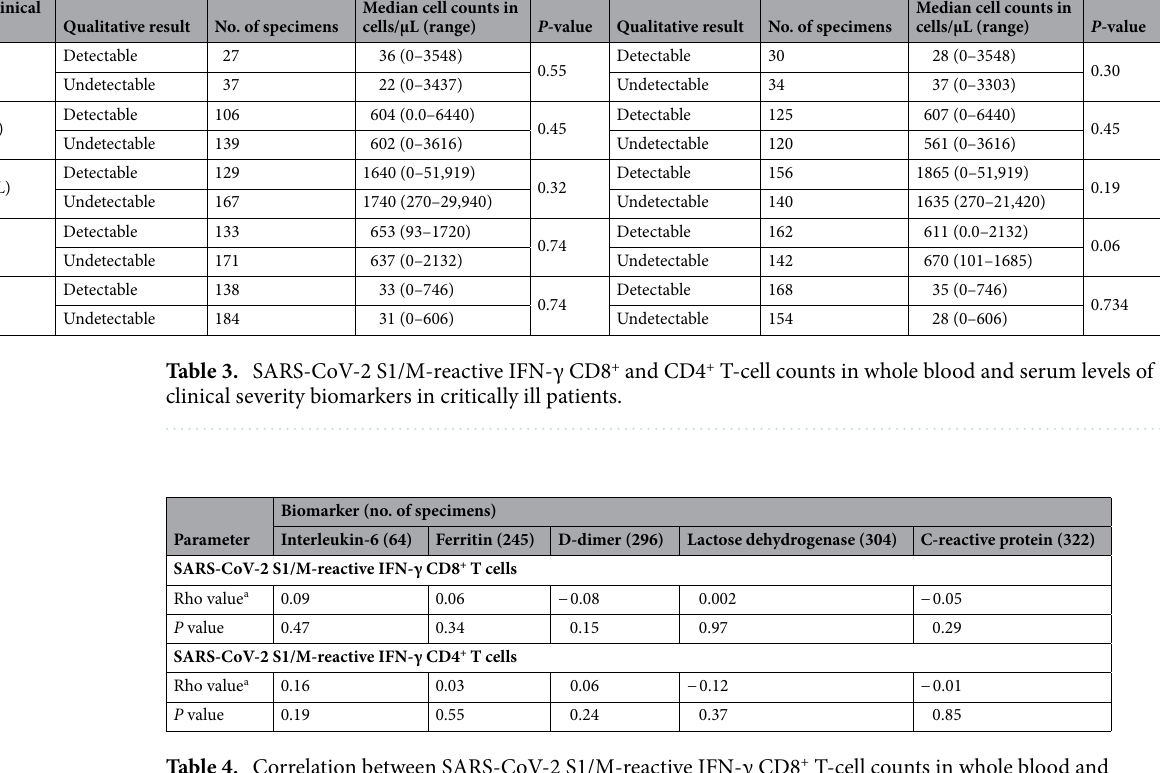
Table 4. Correlation between SARS-CoV-2 S1/M-reactive IFN-γ CD8 + T-cell counts in whole blood and serum levels of biomarkers of clinical severity in critically ill patients. a Spearman rank